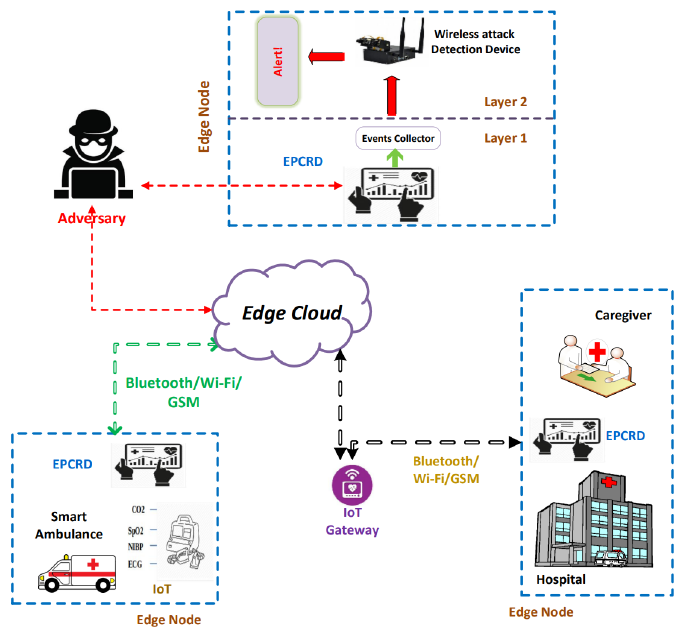
Figure 2. Architecture of the proposed security framework. The proposed system involves an edge cloud for reducing request/response delays. The IDS is multi-level and suits the resource restrictions of IoMT